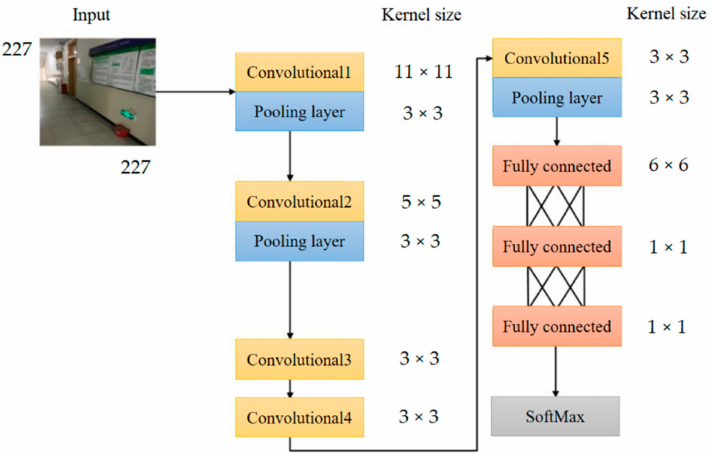
Figure 8. Structure of